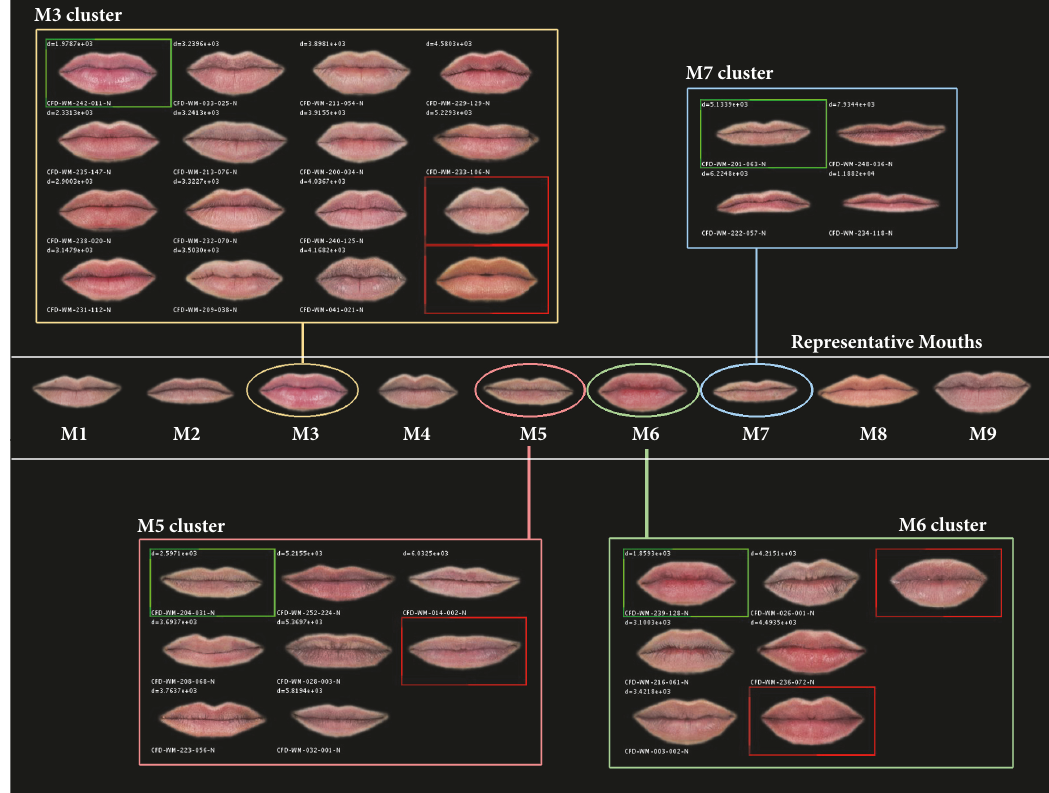
Figure 5: Alleles (representatives) M1 to M9 of the mouths. The mouths belonging to clusters M3, M5, M6, and M7 are shown.